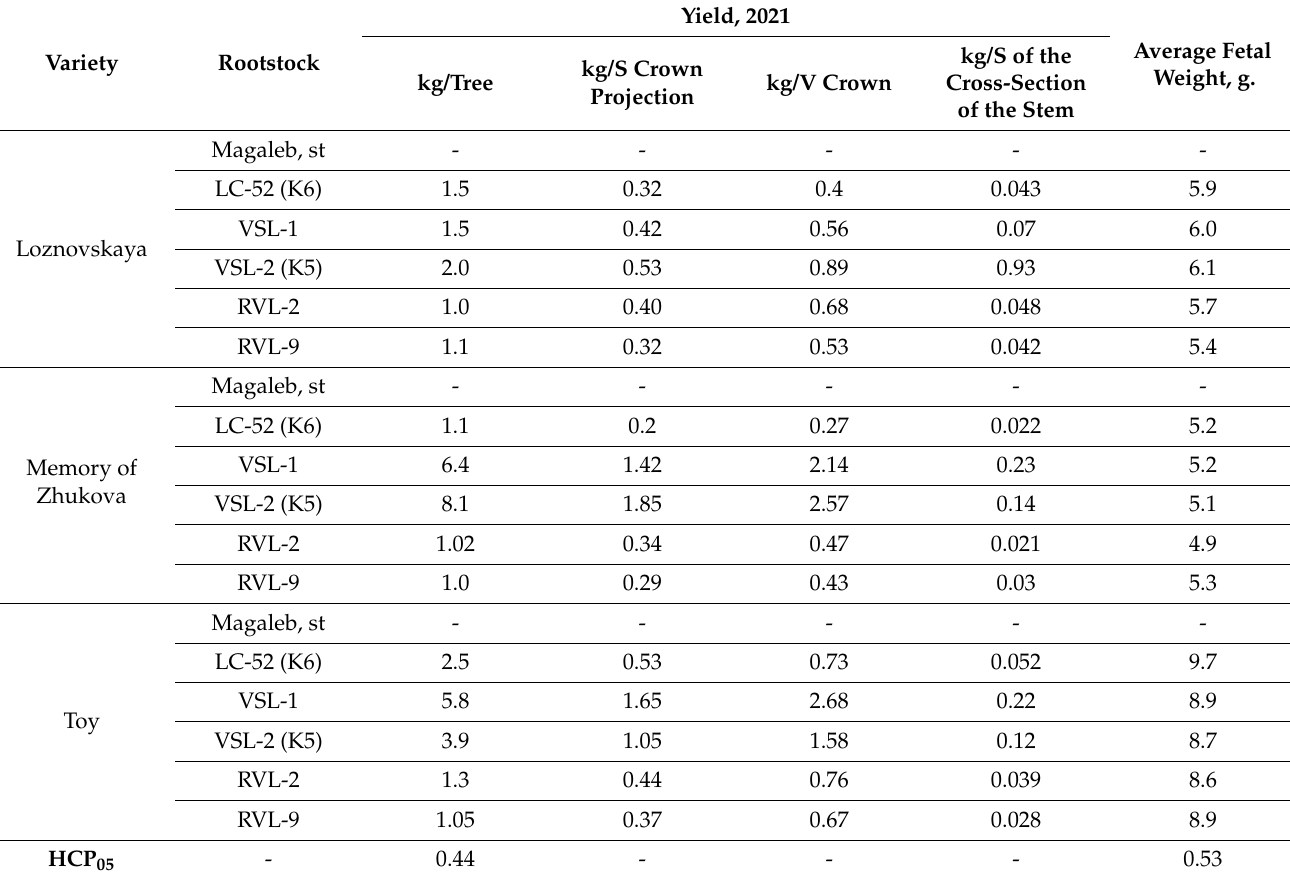
Table 5. Production and quality indicators of variety − rootstock combinations of cherries, 2021